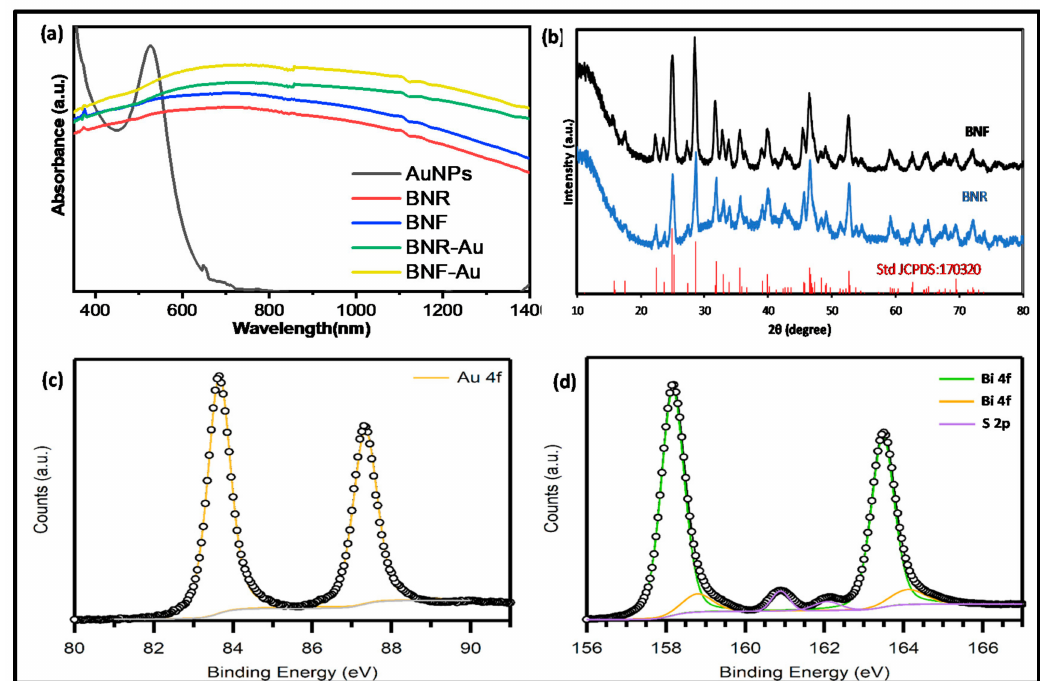
Figure 3. UV-vis absorption spectra of the nanocrystals in toluene ( a ), XRD pattern of BNR and BNF ( b ), and the representa- tive high resolution XPS spectra of Au4f, ( c ), S 2p and Bi4f for BNF-Au ( d